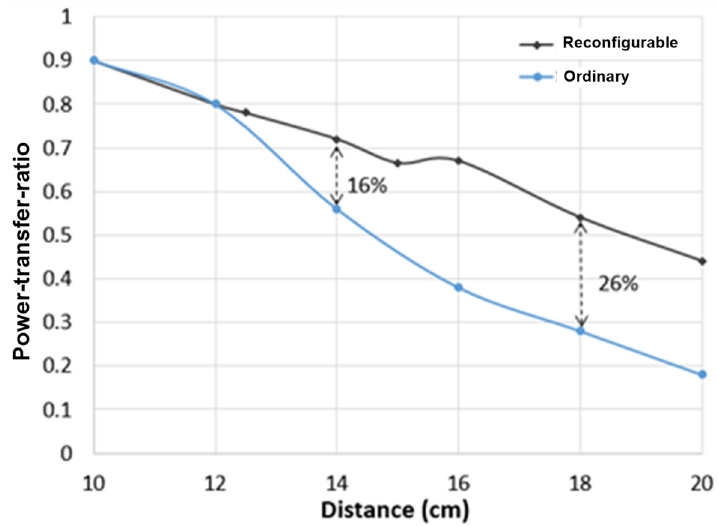
Figure 13. Measured power-transfer ratio from the transmitter coil to the receiver coil versus trans- mission distance.